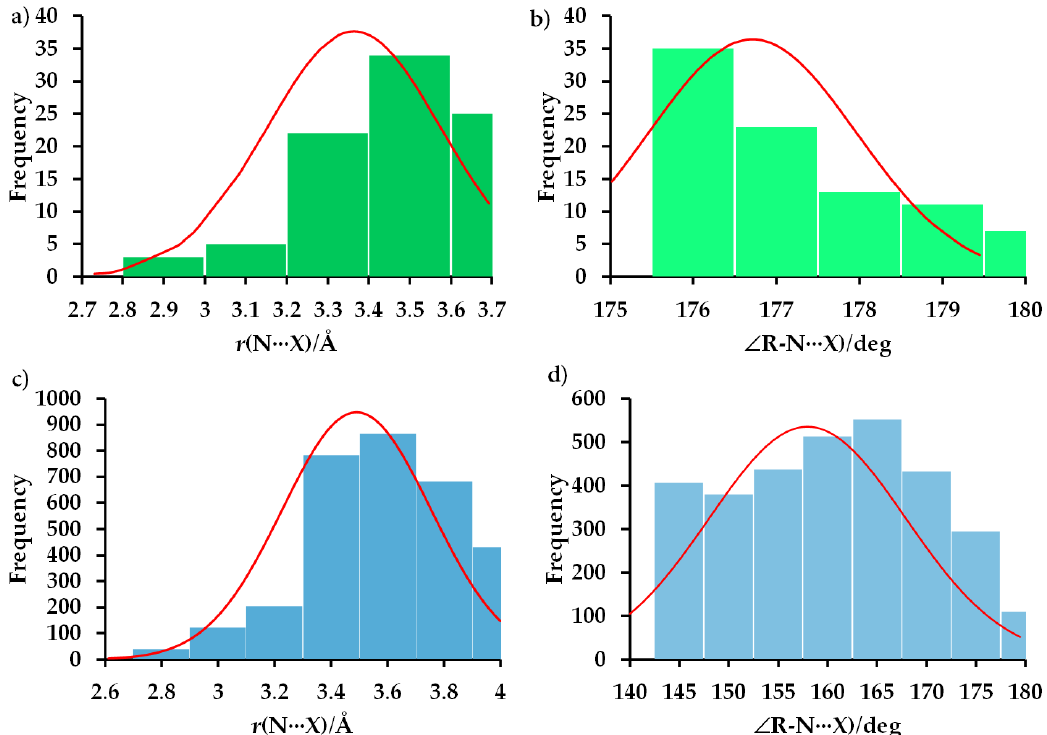
Figure 27. ( a , b ) Histograms illustrating the intermolecular distances r (N···X) and intermolecular bond angles R – N···X (X = F, Cl, Br, I) for 81 hits (89 close contacts) found in a CSD search for the ranges 2.6 – 3.7 Å and 175 – 180°, respectively. Shown in ( c , d ) are the corresponding plots for 3122 geometric instances in 1690 crystals found with ranges of 2.6 – 4.0 Å and 140 – 180°, respectively. Po- tential false contacts in ( c , d ) have not been identified and omitted.